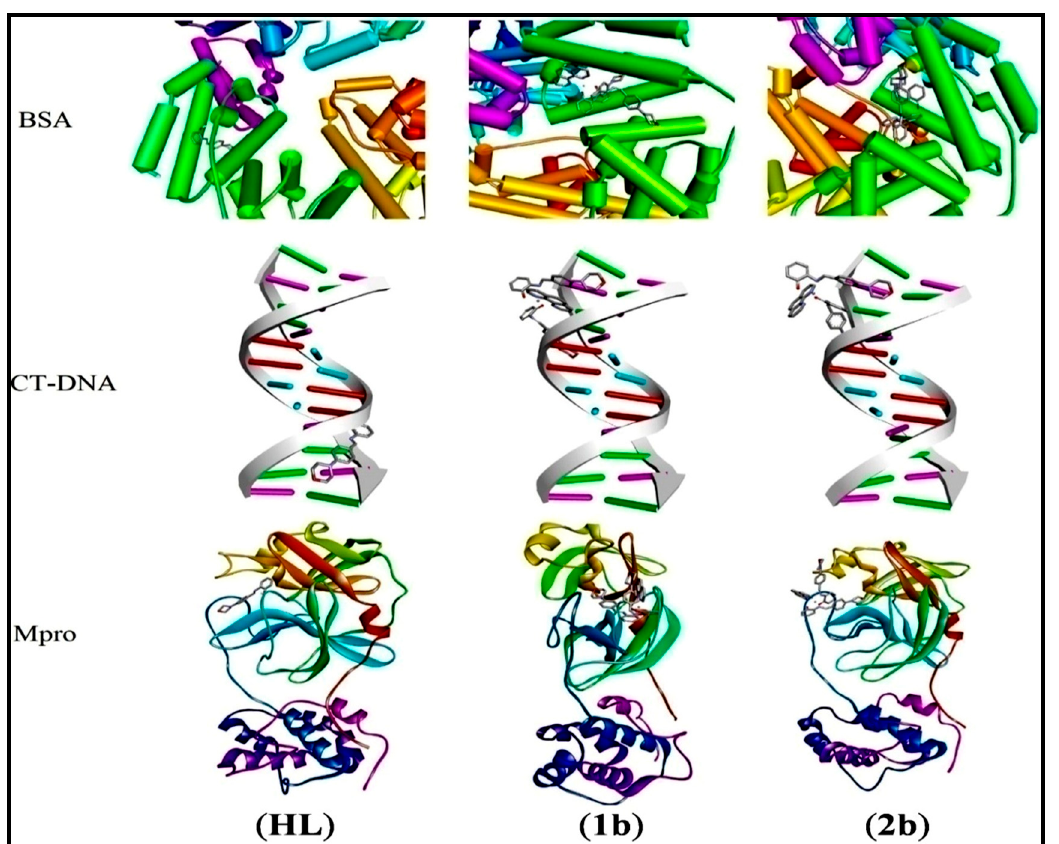
Figure 10. The schematic structures of the three biomacromolecules considered for docking studies of ligand ( HL ) and complexes ( 1b – 2b ). Only one protomer of the dimeric Mpro enzyme is provided.